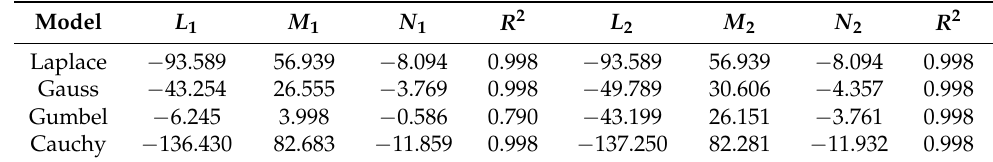
Table 1. The fitting parameters and determination coefficients ( R 2 ) at a significance level of 0.01 of Equations (8) and